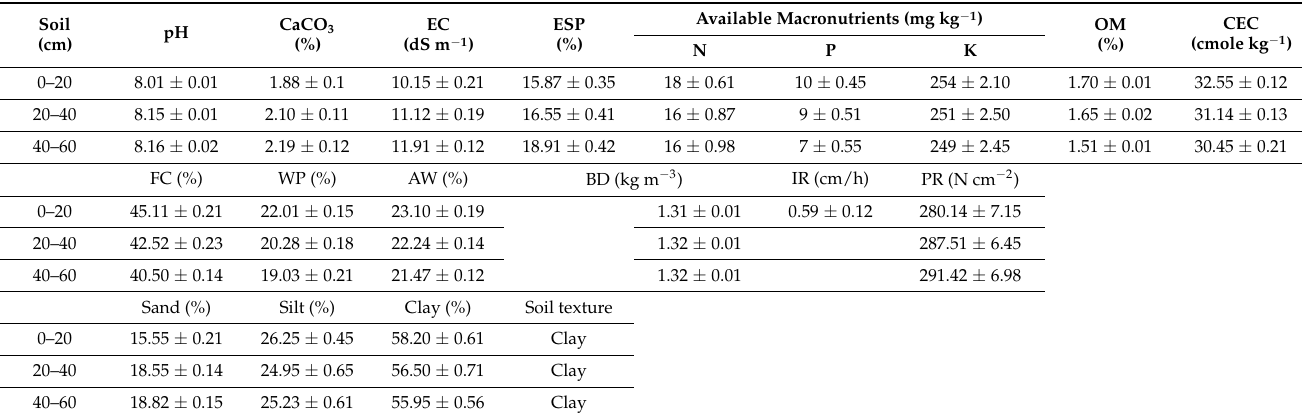
Table 1. Some physical and chemical properties of the soil before the experiment.